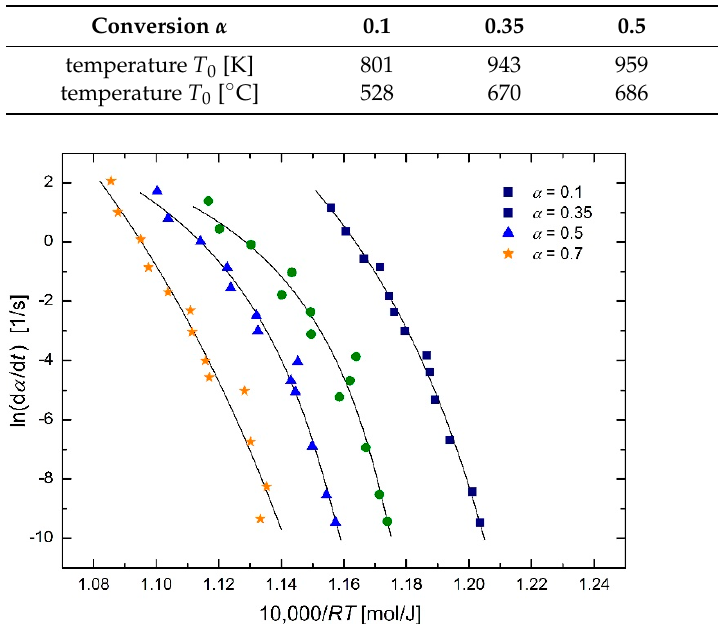
Figure 5. Arrhenius plot for austenitization of SA 508 Gr.3 steel using isoconversional method [2] based on the modified Arrhenius equation in the form of Equation (27). Table 1. T 0 temperatures for different conversions corresponding to the plots in Figure 5.